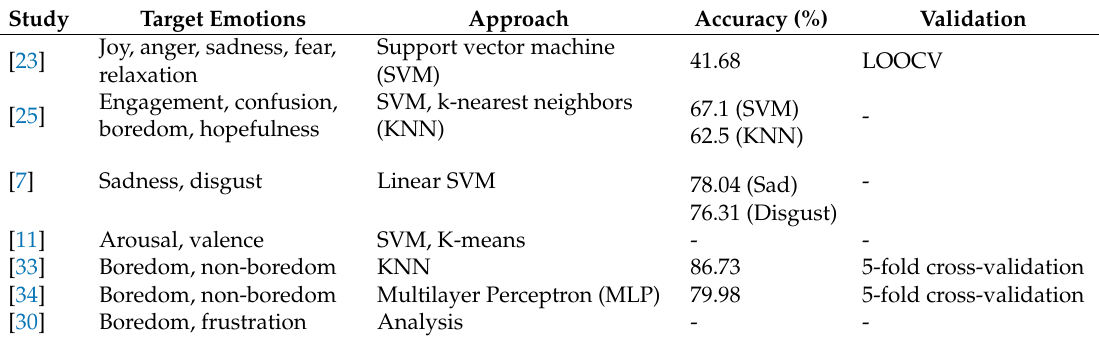
Table 1. Emotion classification of healthy people based on EEG data (up to four